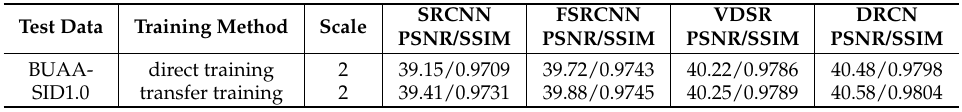
Table 11. Comparison of different training methods.